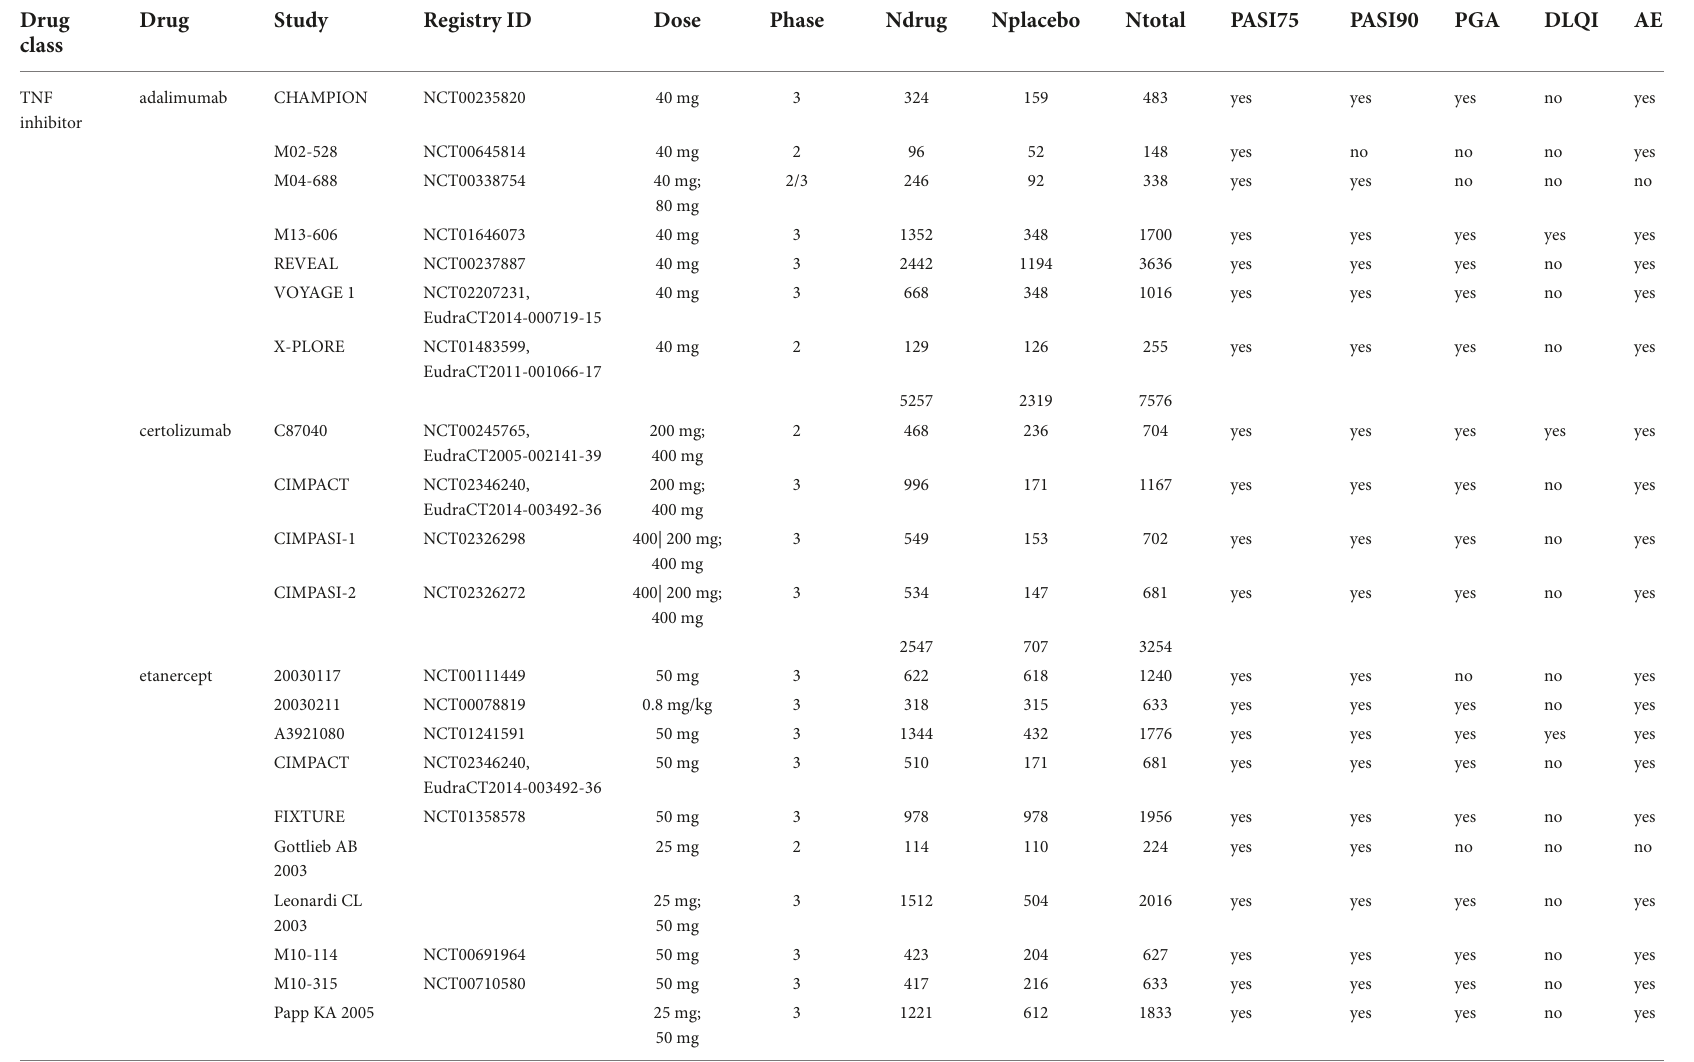
TABLE 1 Overview of adult psoriasis studies used for comparison against pediatric psoriasis